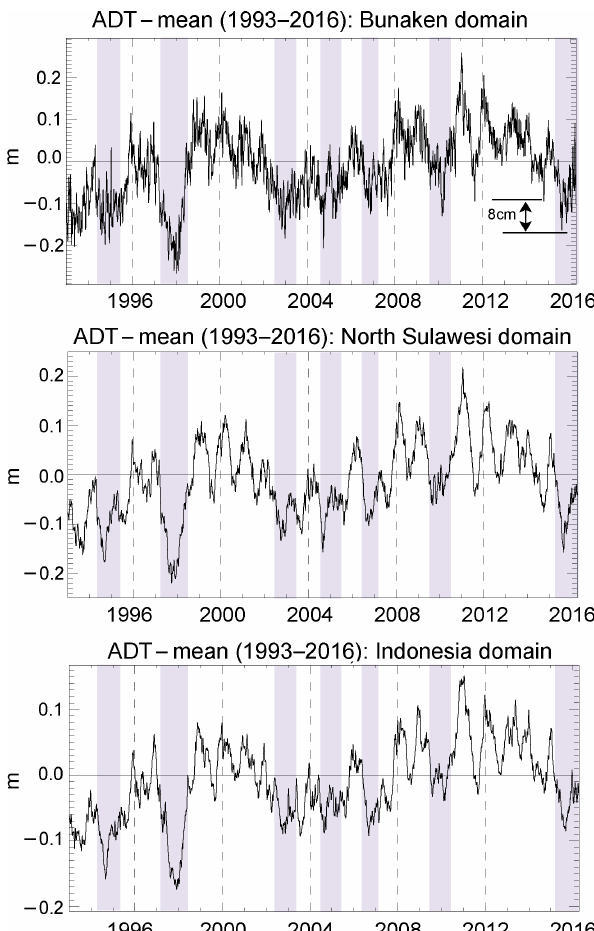
Figure 4. Time series of ADT, minus the mean over the 1993–2016 period, for Bunaken Island (top), North Sulawesi (middle), and In- donesia (bottom). The corresponding spatial domains are shown in Fig. 6. El Niño periods (http://www.cpc.ncep.noaa.gov/products/ analysis_monitoring/ensostuff/ensoyears.shtml) are depicted with grey shadings. The September 2015 minimum corresponds to an 8cm fall compared to the minima then four previous years, and a 14cm fall compared to the 1993–2016 mean. The 1998 El Niño displays the largest sea level fall.